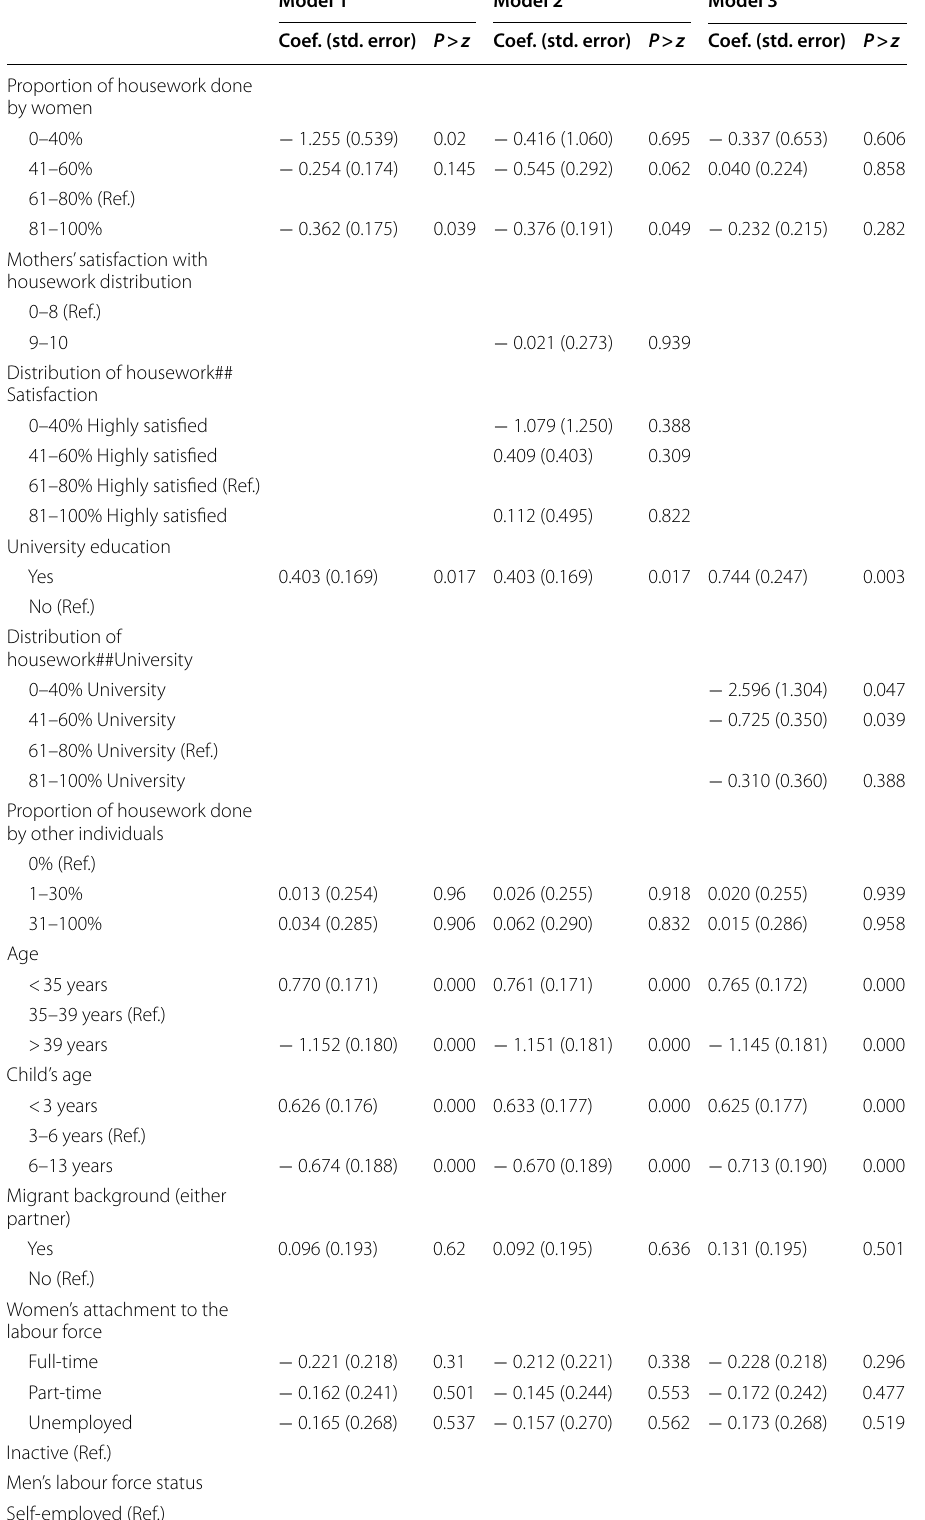
Table 2 Logit models: housework Model 1 Model 2 Model